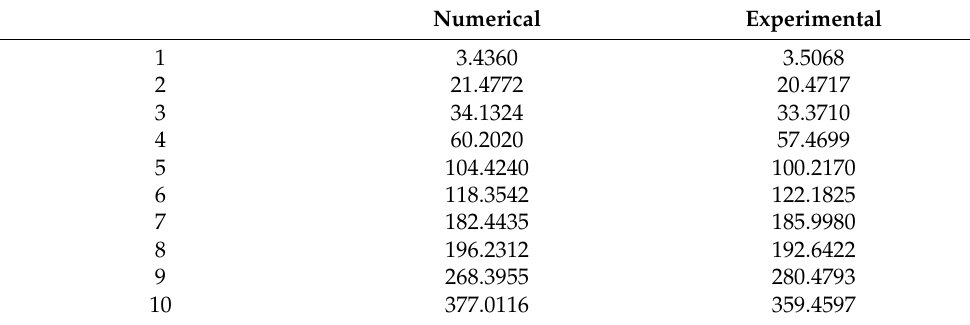
Table 3. Numerical and experimental values of natural frequencies of the system for 50% draught. Numerical